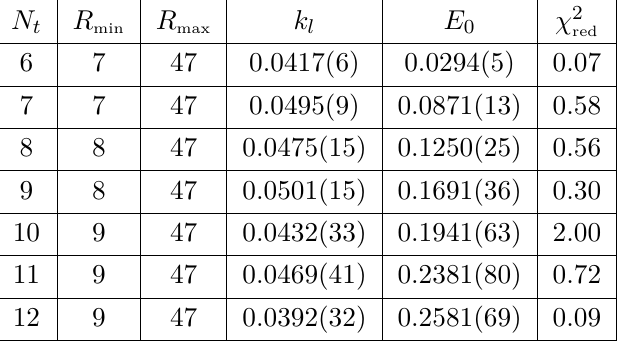
Table 7 . Best-fit estimates for E 0 for different values of N t at β = 9 .